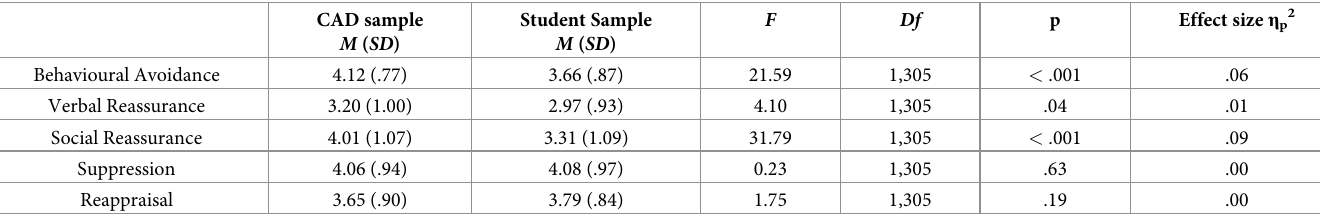
Table 6. Post-hoc comparison of the children with anxiety disorder and student